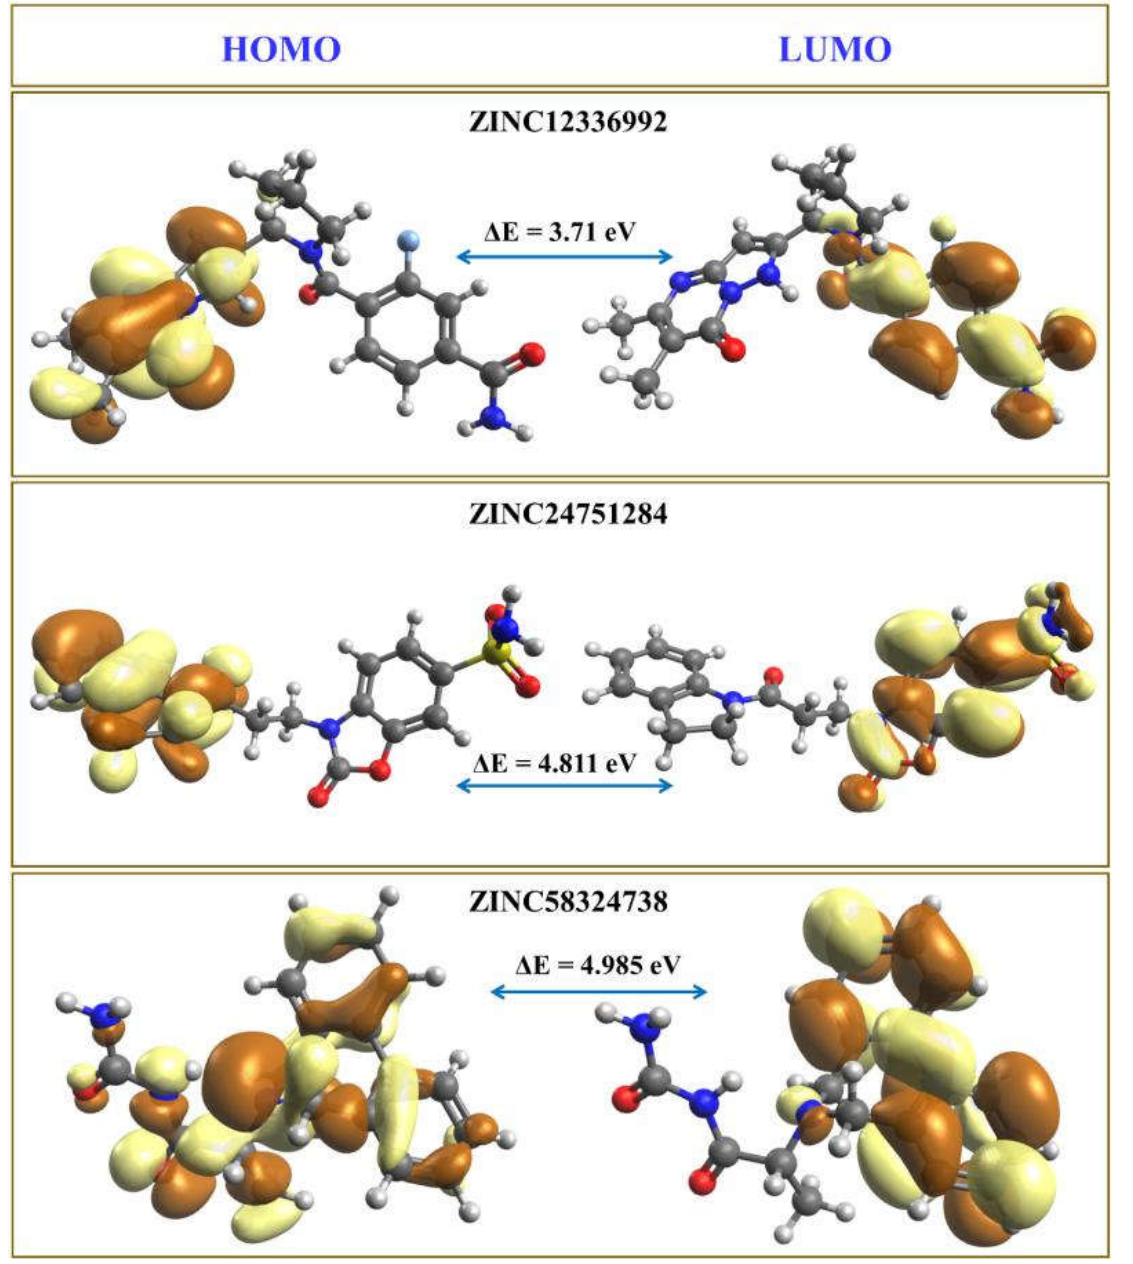
Figure 10. HOMO and LUMO orbitals of the top three hits. The positive and negative phases of the molecular orbitals are represented by the brown and light-yellow colors,